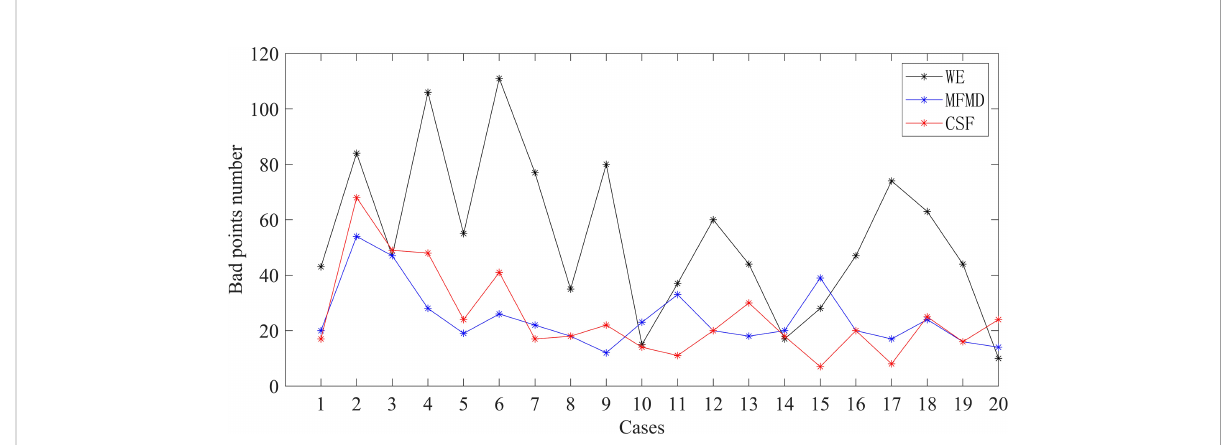
FIGURE 8 The number of outliers detected by the three methods (the black, blue and red lines represent the number of outliers detected by method WE, MFMD and CSF